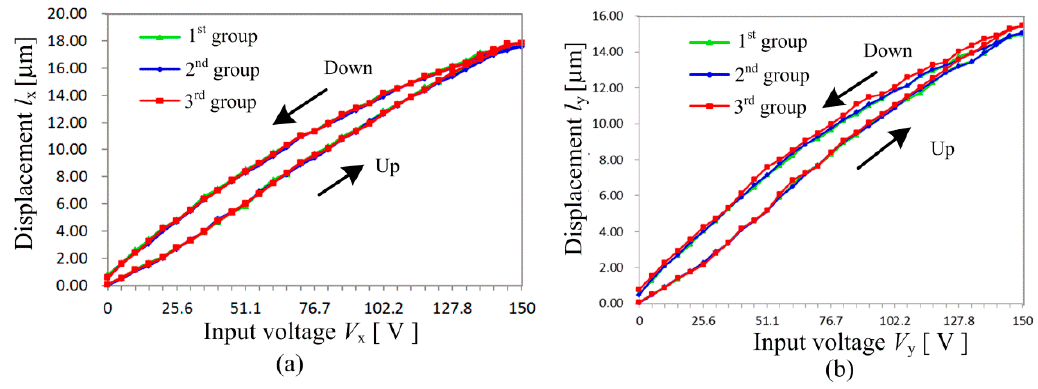
Figure 8. Motion performance: ( a ) x -stage; ( b ) y -stage.